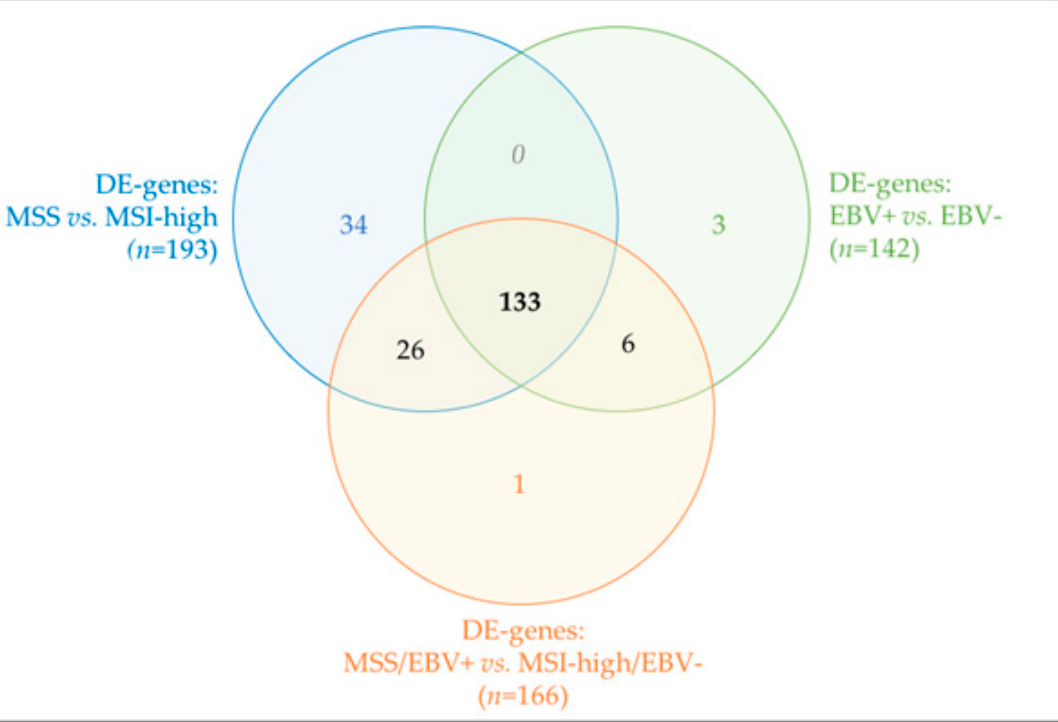
Figure 6. Venn diagram for shared (or not) DE-genes across the three analyses performed. 2.5. PD-L1 and PD-1 Displayed Opposite mRNA Expression Patterns and Were Differently Associated